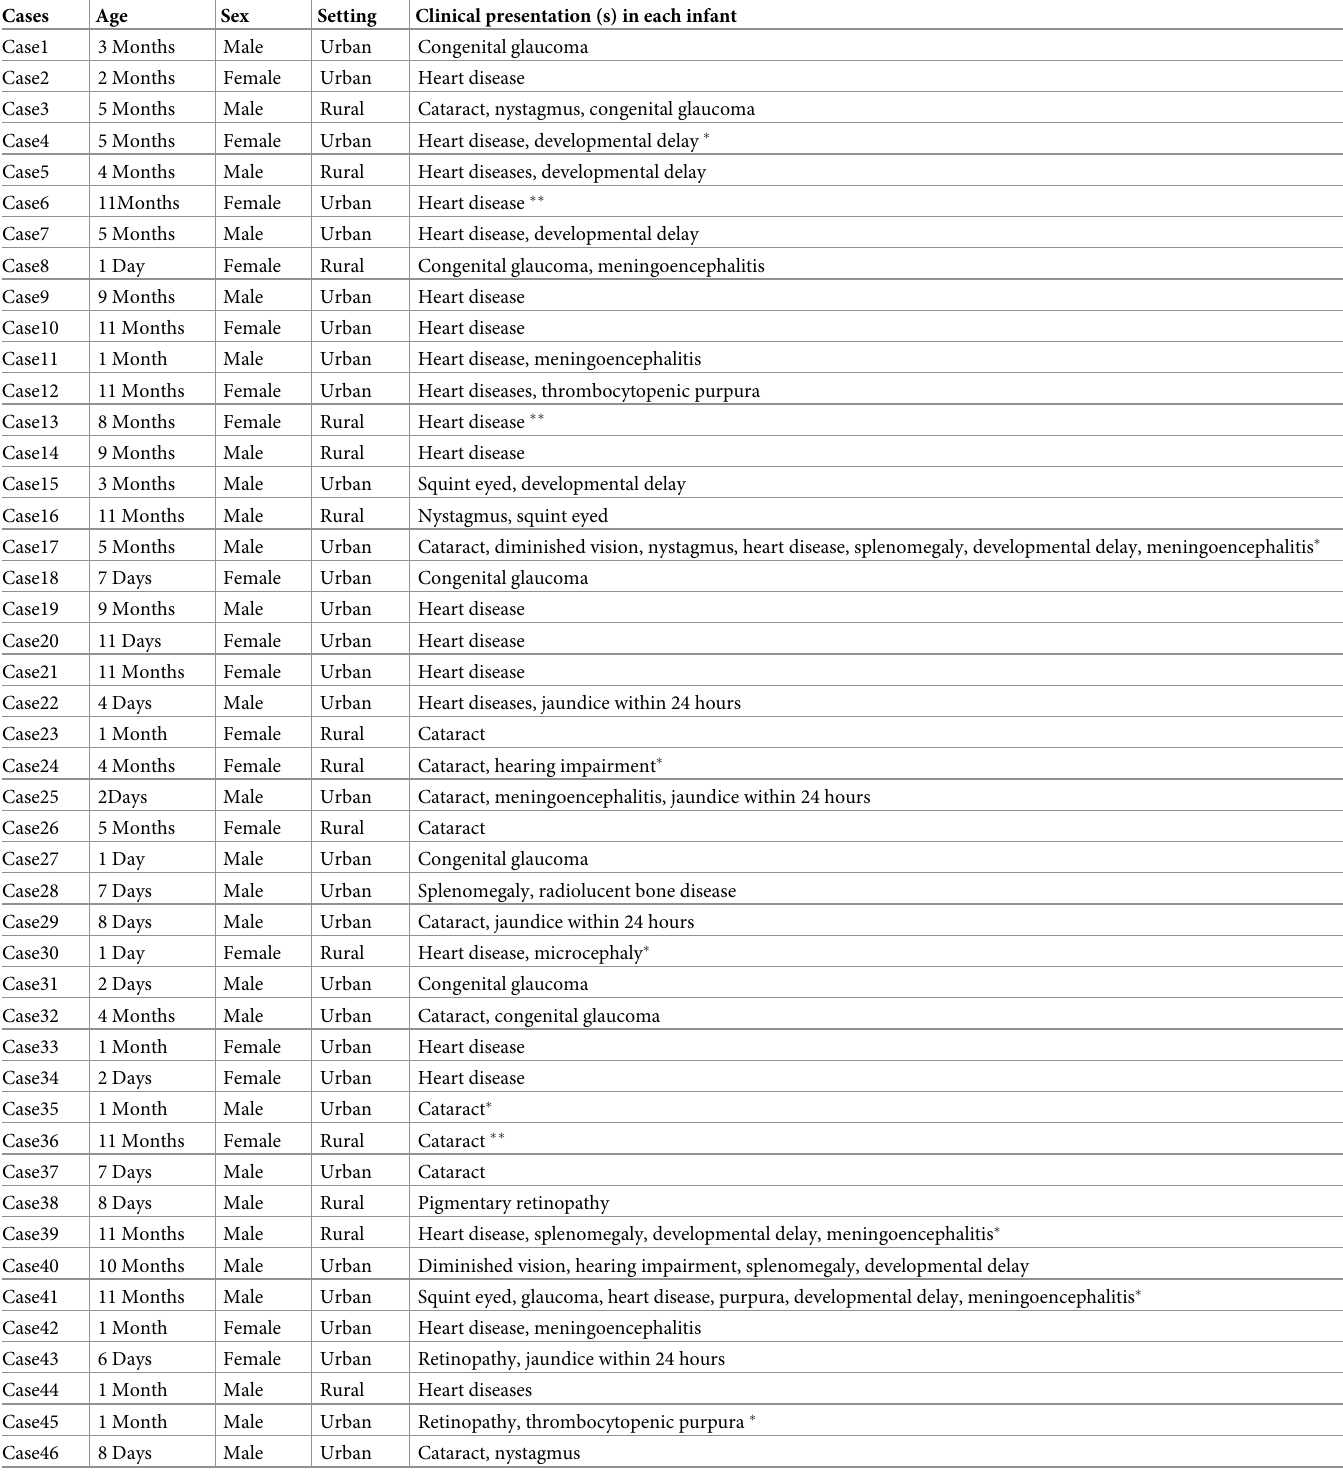
Table 3. The overall clinical presentations of each infant suspected for CRS in Amhara Regional State Referral Hospitals, Northwest Ethiopia, December 2015-August